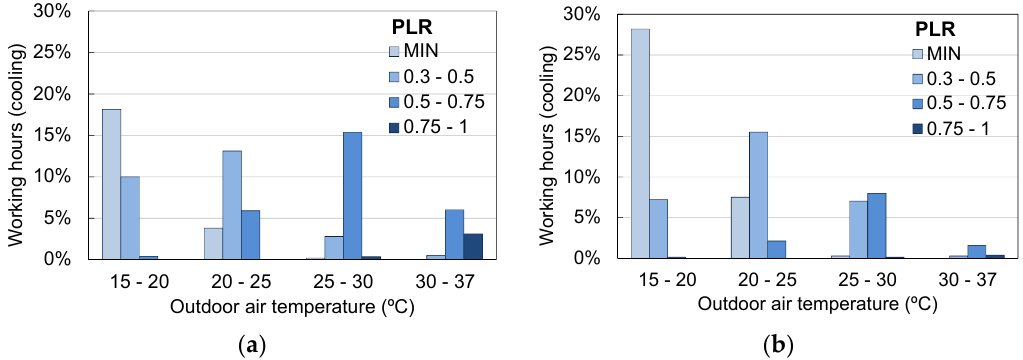
Figure 9. Working hours at partial load (cooling) grouped into outdoor temperature ranges for Madrid (a) and Barcelona (b).